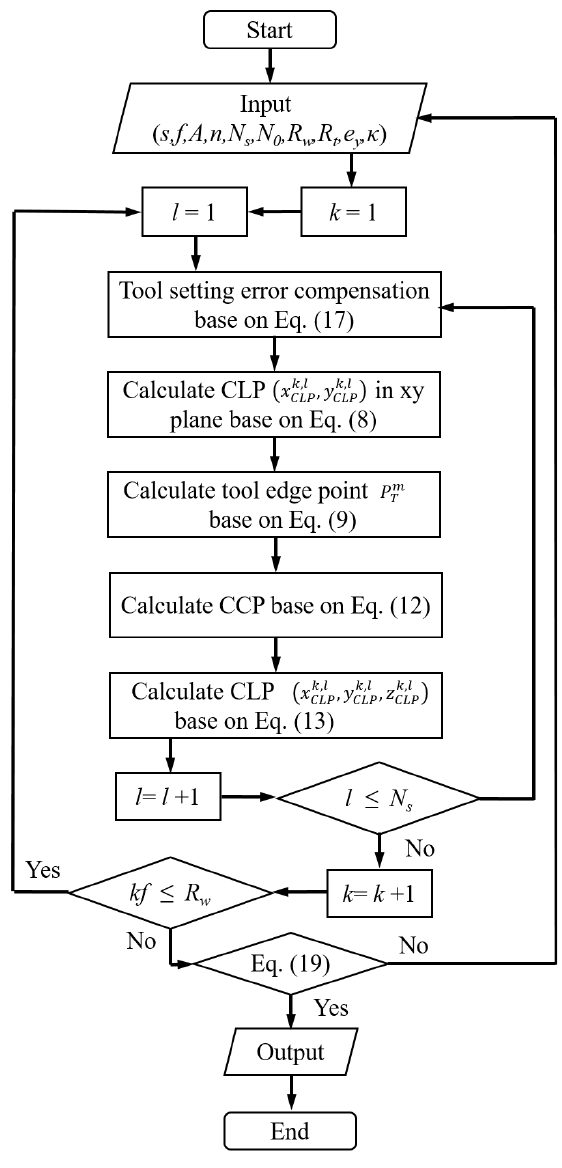
Figure 3. Flow chart for the toolpath